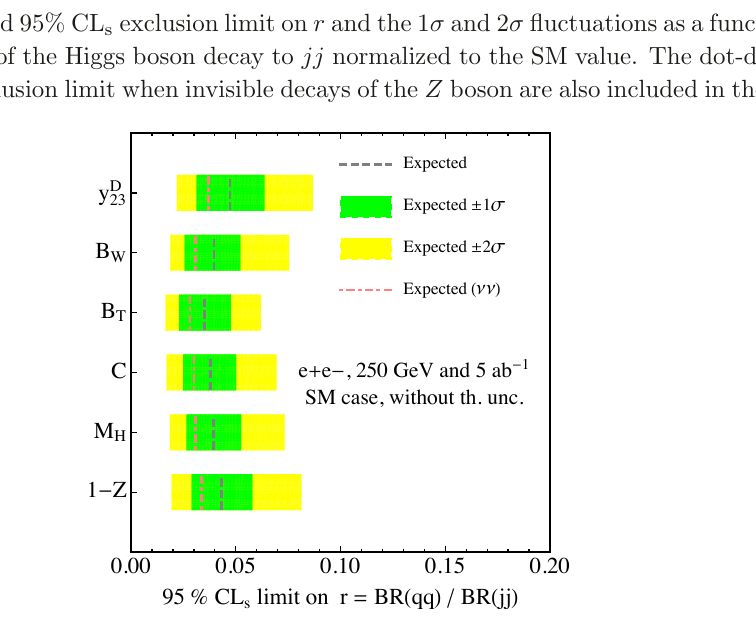
Figure 4 . Expected 95% CL s exclusion limit on r and the 1 σ and 2 σ fluctuations based on measurements of different event shape observables and assuming a theory of the SM. Theoretical uncertainties on the event shape distributions are not